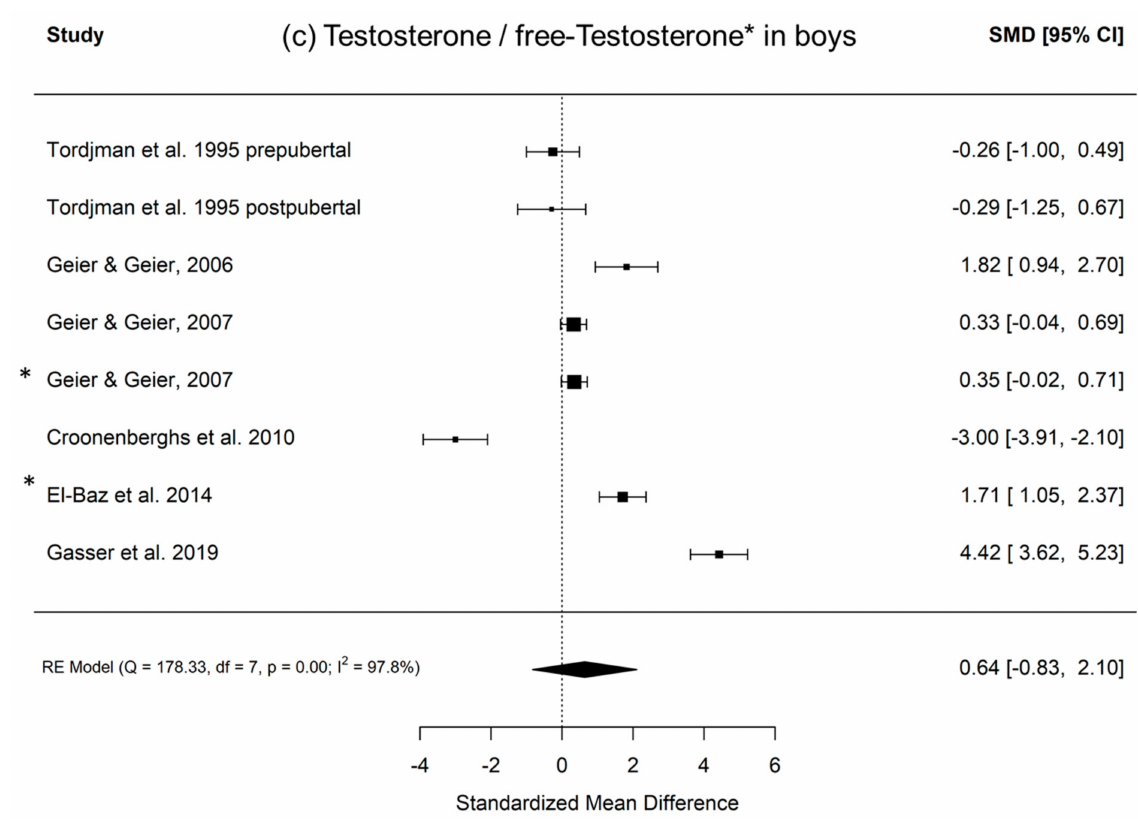
Figure 3. ( a – c ) Random effects models with significance level, Cochrane Q, I 2 , and effect sizes of analyzed metabolites in boys with autism versus healthy controls. ( a ) Androstenedione/androstenediol indicated with *; ( b ) DHEA/DHEA-S indicated with *, DHEA-C indicated with **; ( c ) testosterone/free testosterone indicated with